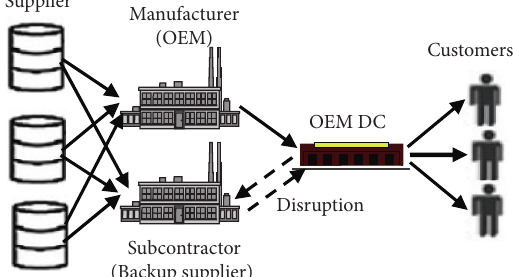
Figure 1: The virtual dual-source production inventory